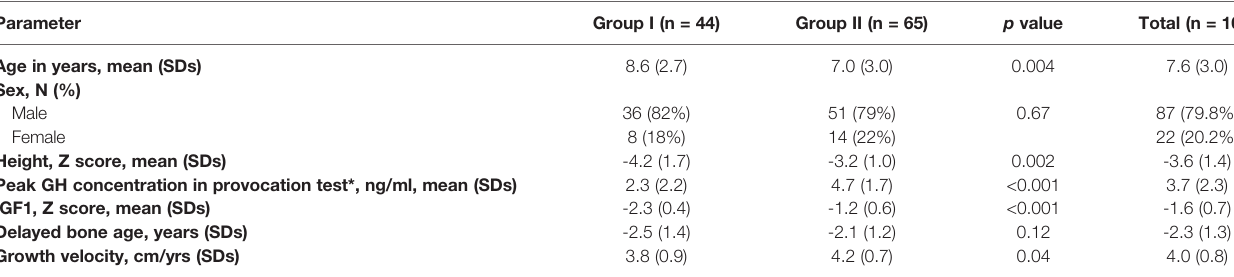
TABLE 1 | Demographic and clinical characteristic of GHD